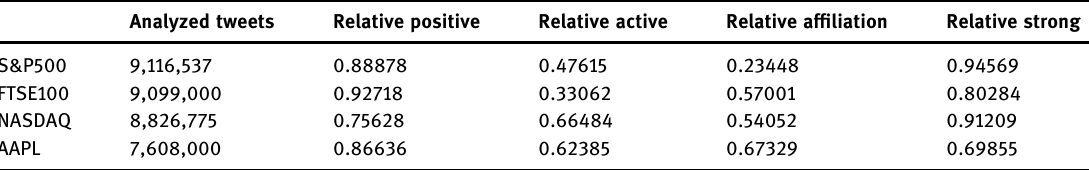
Table 2: F - statistics for the hypothesis H 0 : the asset returns do not Granger cause the changes in